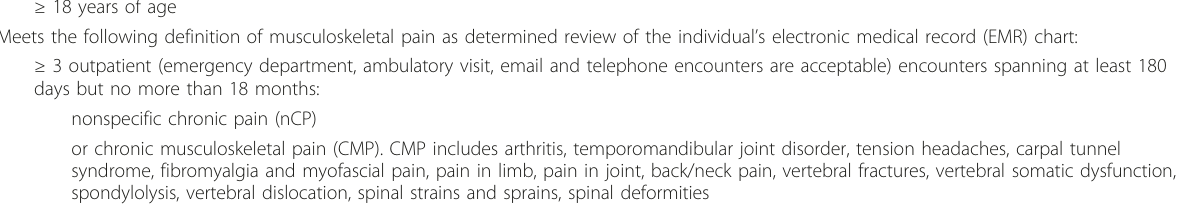
Table 1 Overall Study Eligibility Criteria Inclusion